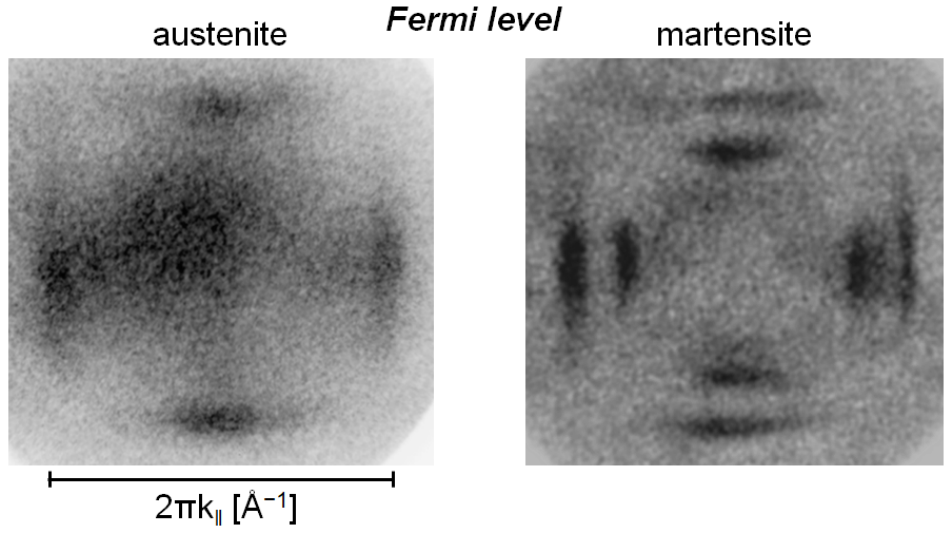
Figure 1. Equi-energy cuts (EEC) at Fermi level of austenite and martensite phase of Ni 49 . 7 Mn 29 . 1 Ga 21 . 2 .